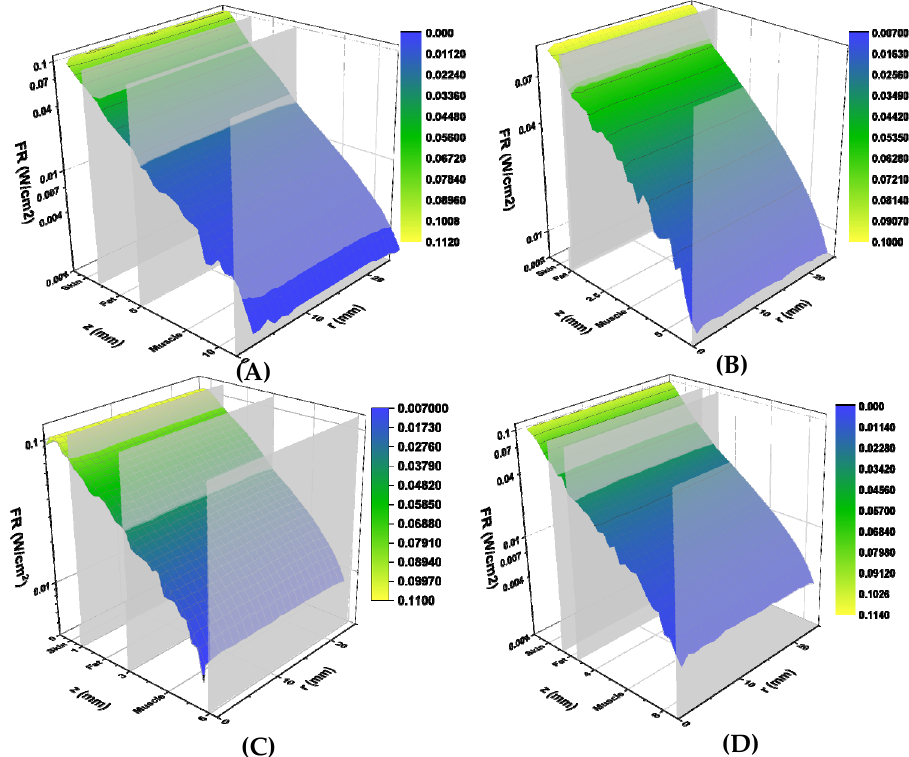
Figure 4. Simulated fluence rates (W/cm 2 ) for volunteers 1 ( A ), 2 ( B ), 3 ( C ) and 4 ( D ). Calculated fluence rates are displayed on the vertical axis, tissue depth (mm) is displayed on the z axis, and lateral tissue radius (mm) is displayed on the r axis. Tissue boundaries are labelled on the tissue depth axis. Graphs are colour-coded based on fluence rate, with yellow corresponding to higher fluence and blue to lower fluence rates.